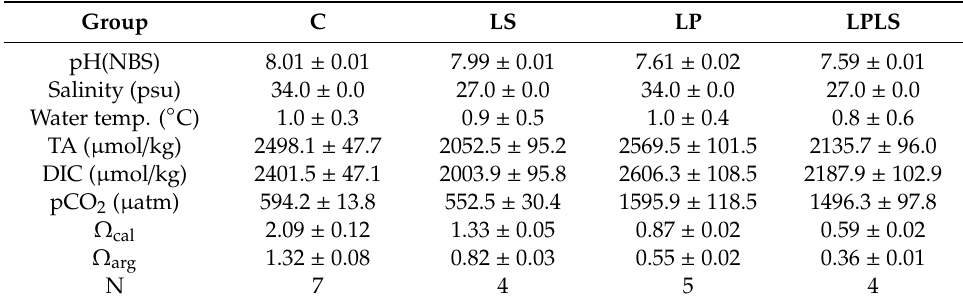
Table 1. The water quality of sampled experimental seawater (mean ± SE). Group C